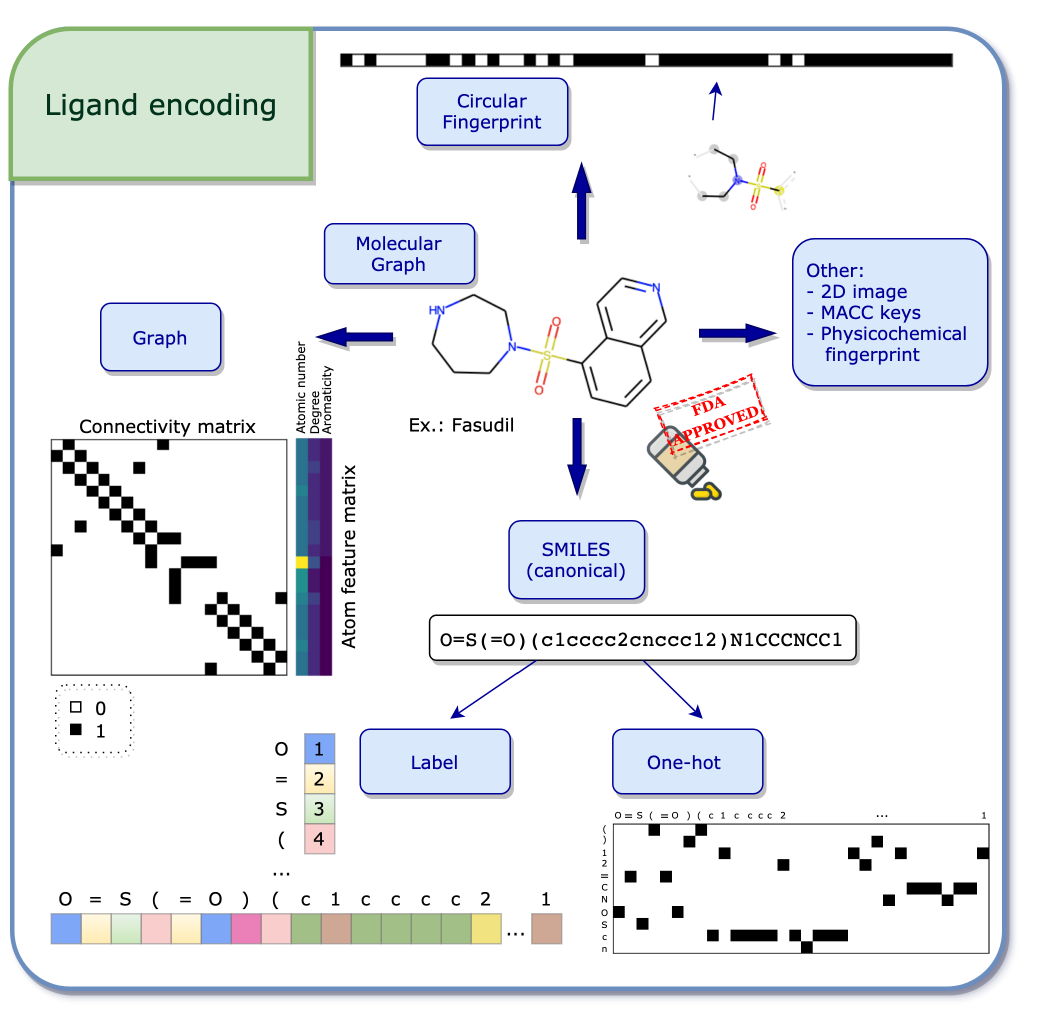
Figure 2. Ligand encoding. Having a computer-readable format is one of the starting points for machine—and deep— learning. The example molecule is the FDA–approved drug Fasudil [55] taken from the PKIDB database [56]. Recent studies focused on virtual screening (detailed in Section 3) commonly use SMILES, circular fingerprints or graphs to encode the